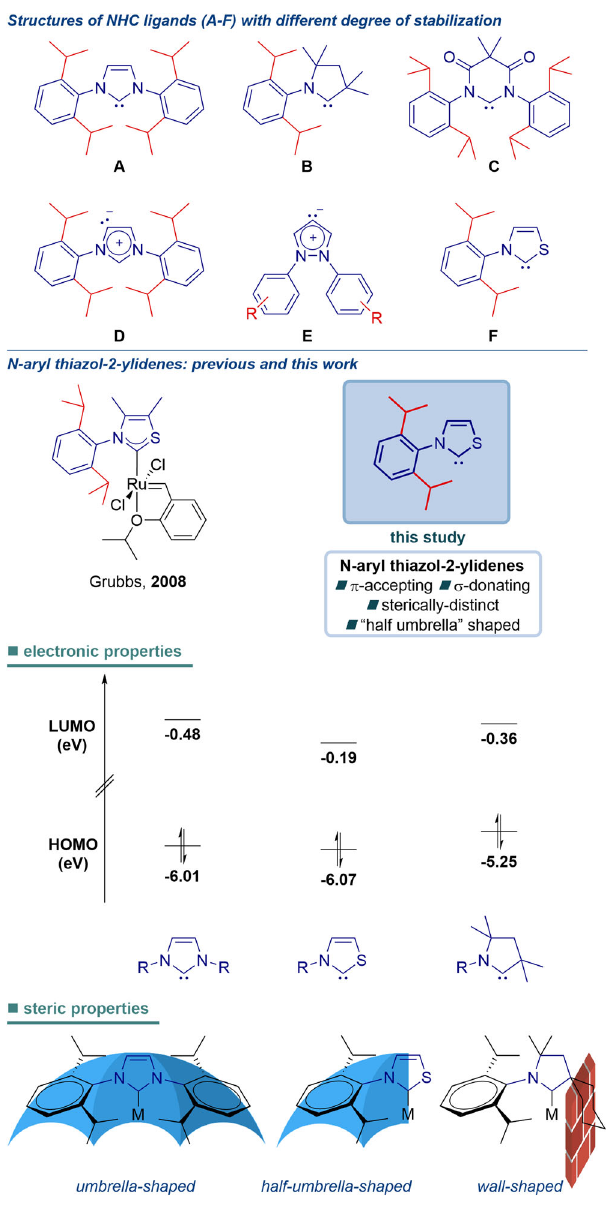
Fig. 1 Structures of N-heterocyclic carbenes with different degrees of stabilization. Energies calculated at B3LYP 6-311 + + g(d,p) level, R =